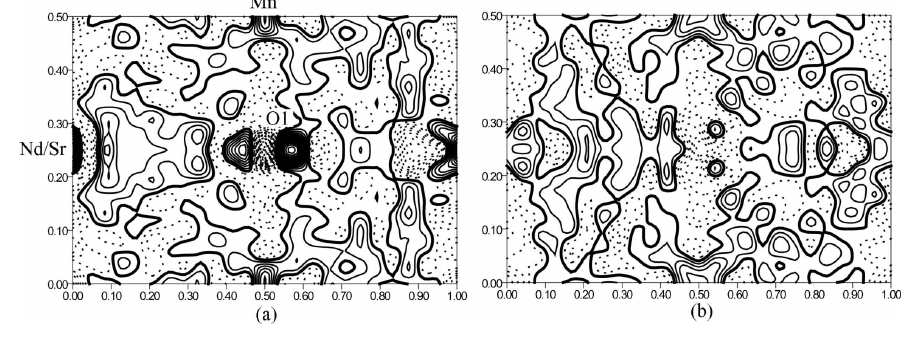
Figure 2 The difference density map projected onto (010) plane with a range 0 < x < 1 and 0< z < 1/2. ( a ): The x -coordinate of O1 is > 1/2. ( b ): The x -coordinate of O1 is < 1/2. Contours are given at intervals of 0.5 e Å -3 . Zero contours are drawn as thick lines, positive contours are drawn as thin lines, and negative contours are drawn as broken line. Neodymium strontium manganese oxide Crystal